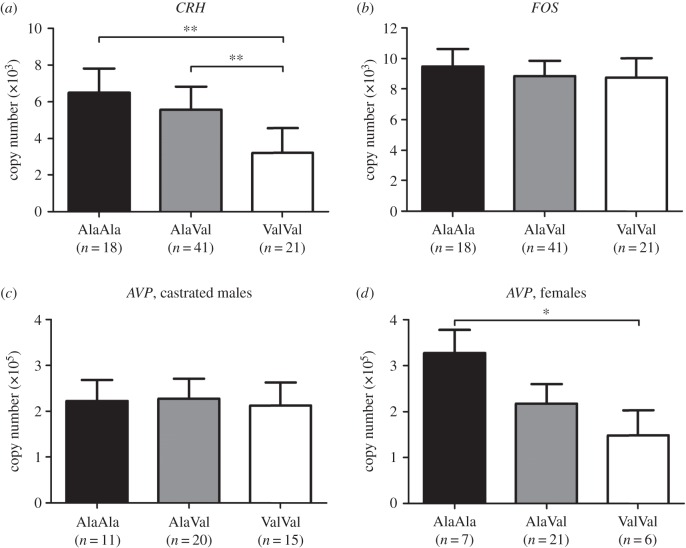
Effect of the GRAla610Val substitution on gene expression in hypothalamus of peripubertal pigs. (a) CRH; (b) FOS; (c) AVP in castrated males; (d) AVP in intact females. Gene expression was measured using quantitative real time PCR. Data are presented as least-squares means ± s.e. *p < 0.05, **p < 0.01.